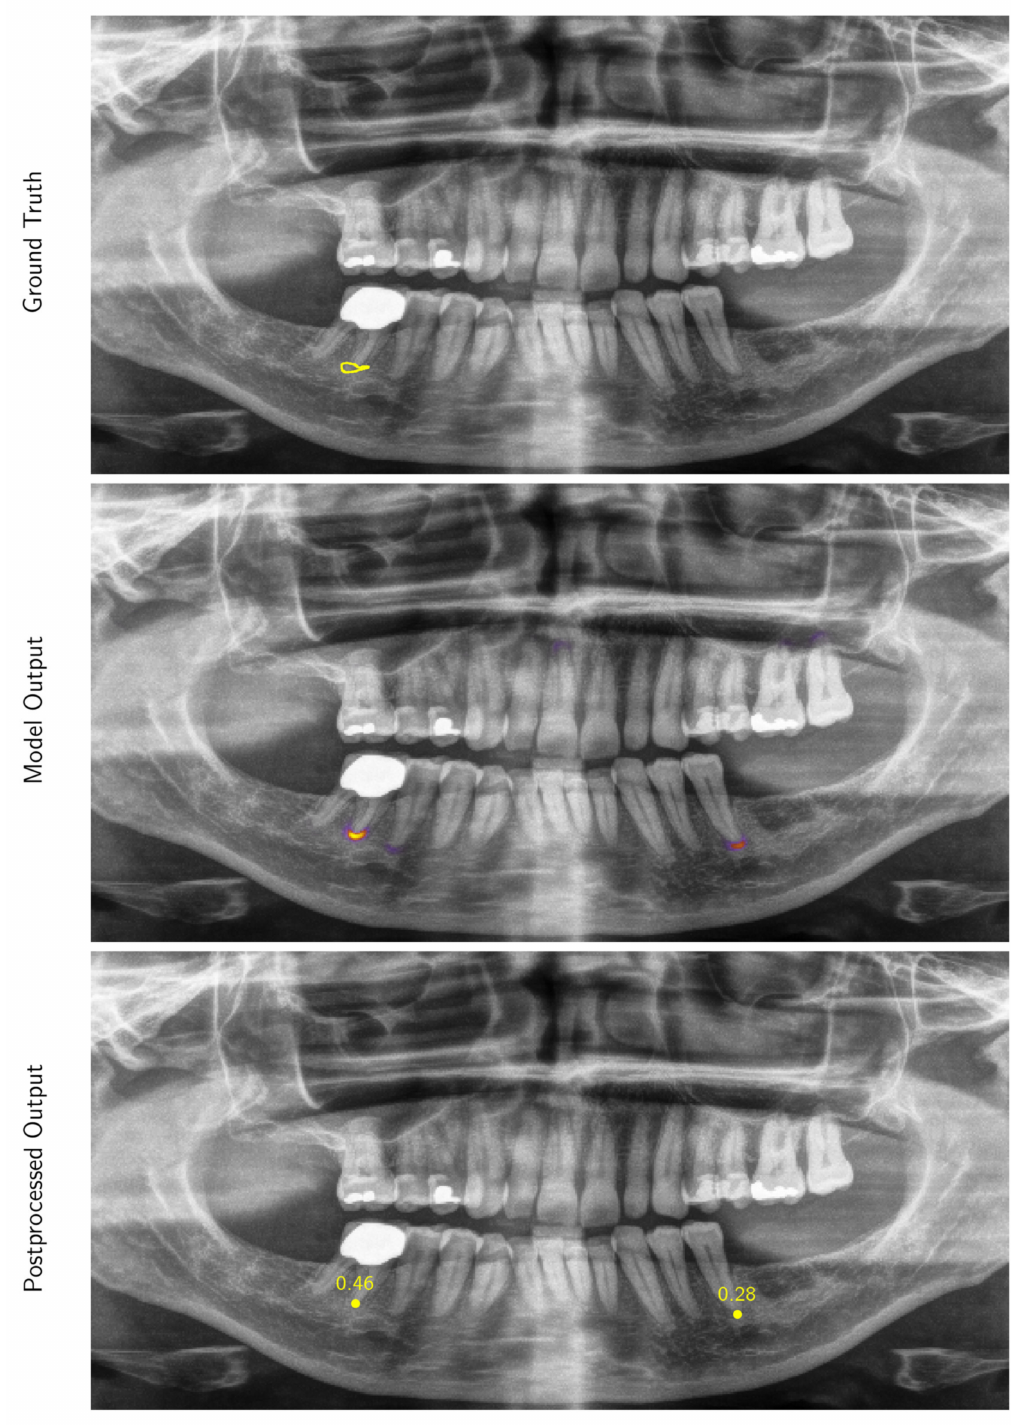
Figure A3. Example 3; see Figure A1 for